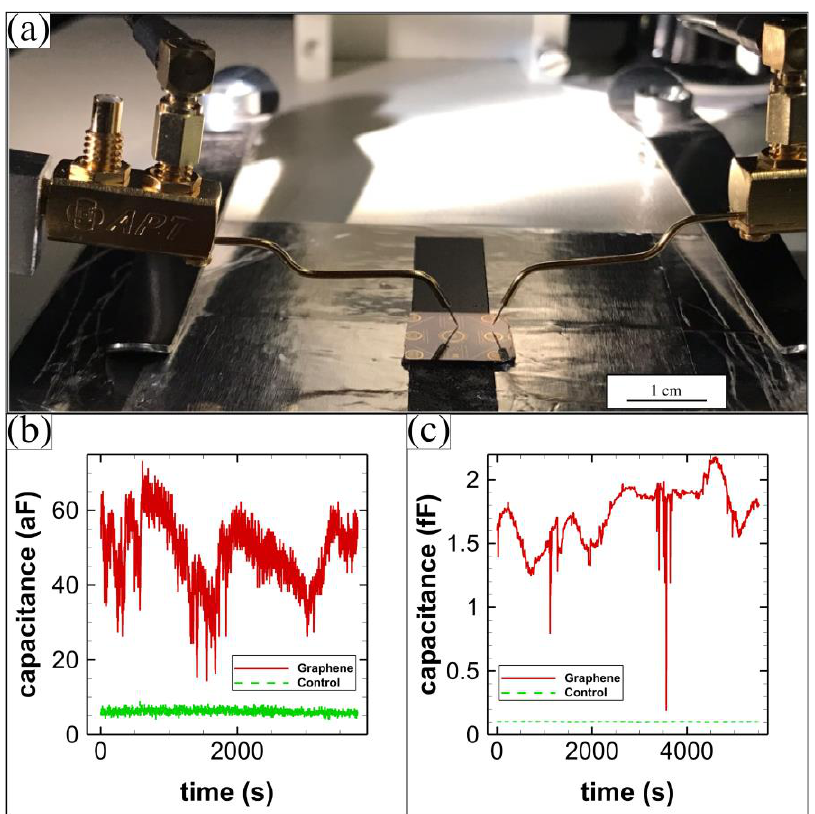
Figure 13. Capacitance measurements. ( a ) Photograph of measurement probes on the wafer; ( b ) ca- pacitance in time for the capacitors made using the 100 mm silicon wafers; and ( c ) capacitance in time for the capacitors made using the TSMC bare die.